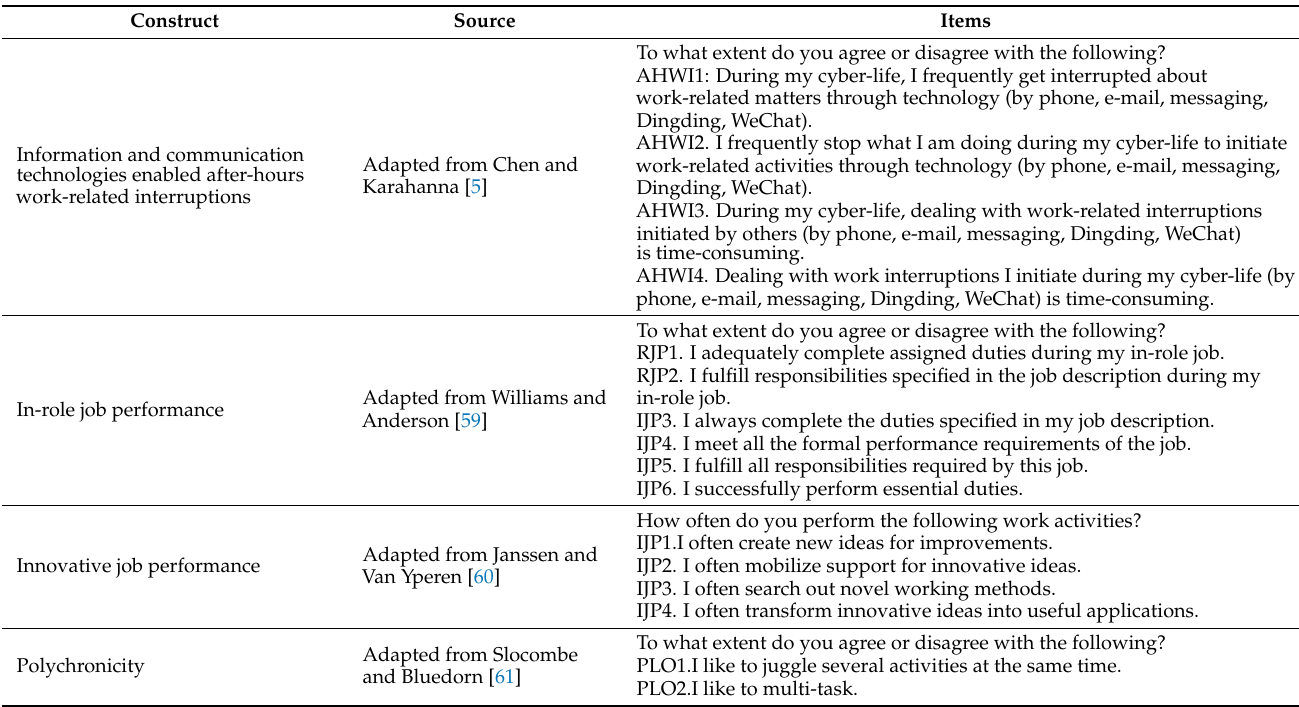
Table A2. Measurement Scales (All scales were measured as 7-point Likert-type scales ranging from strongly disagree to strongly